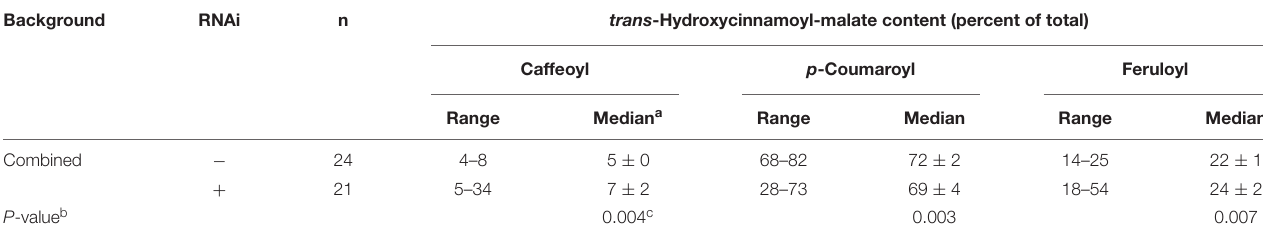
TABLE 4 | Proportion of various hydroxycinnamoyl esters in leaves of plants transformed with HMT and CCOMT RNAi or vector control.